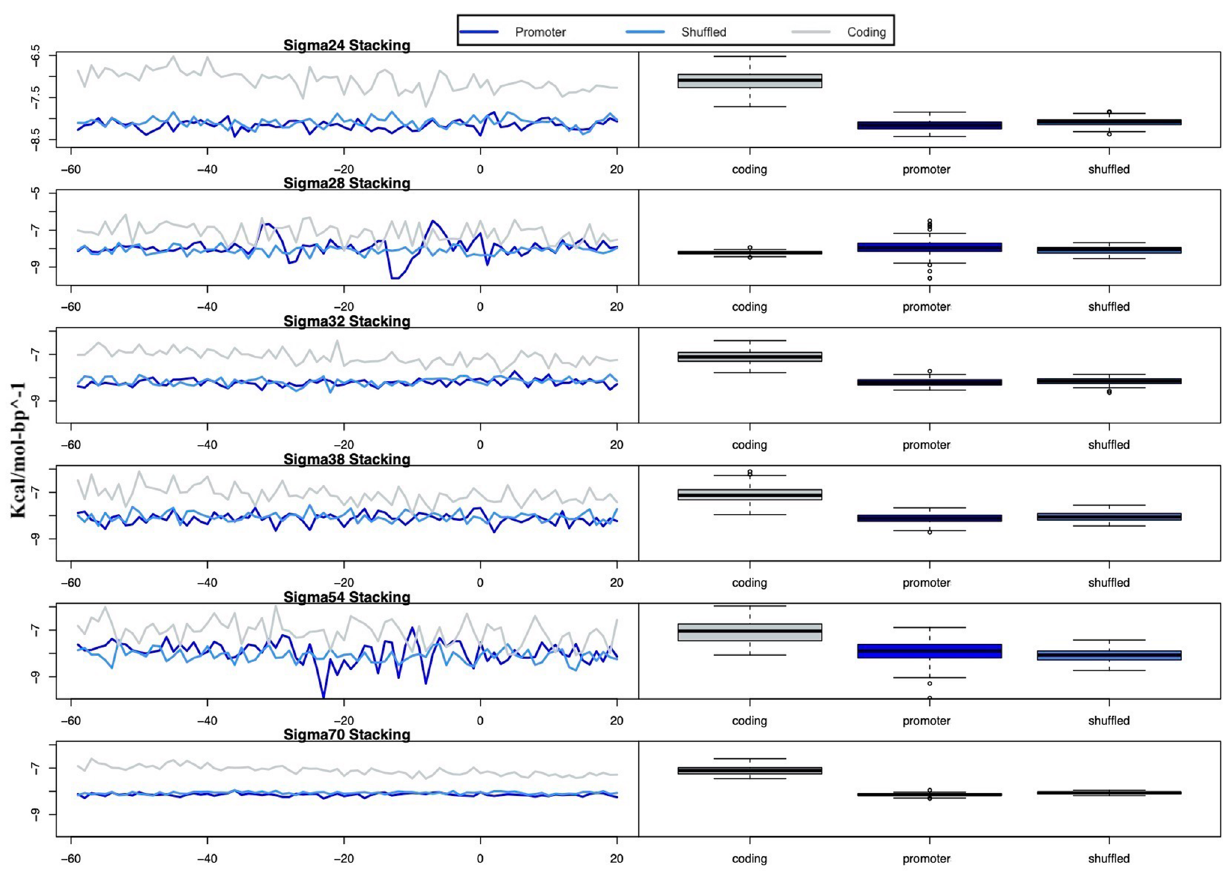
The left panel represents the boxplots of the profiles of promoter, shuffled, and coding sequences, whose Y-axis is in the same scale as the left